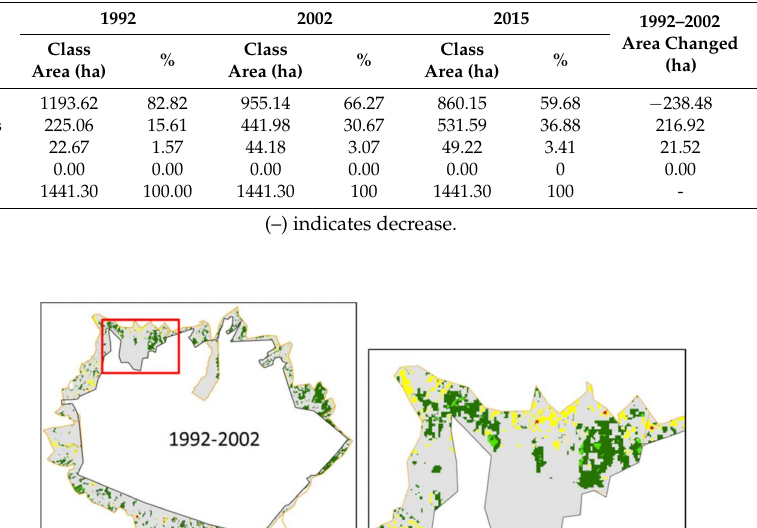
Table 5. Land cover and Percentage of Land Cover Change in Buffer Zone for Mount Makiling Forest Reserve Watersheds in three periods: 1992, 2002, and 2015.